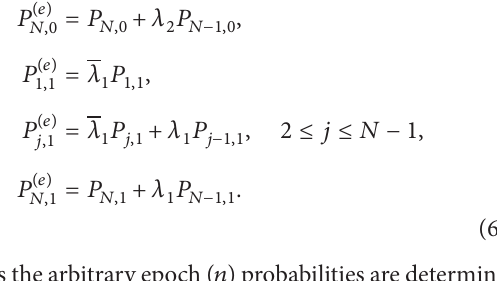
Table 1: System queue length distribution at various epochs